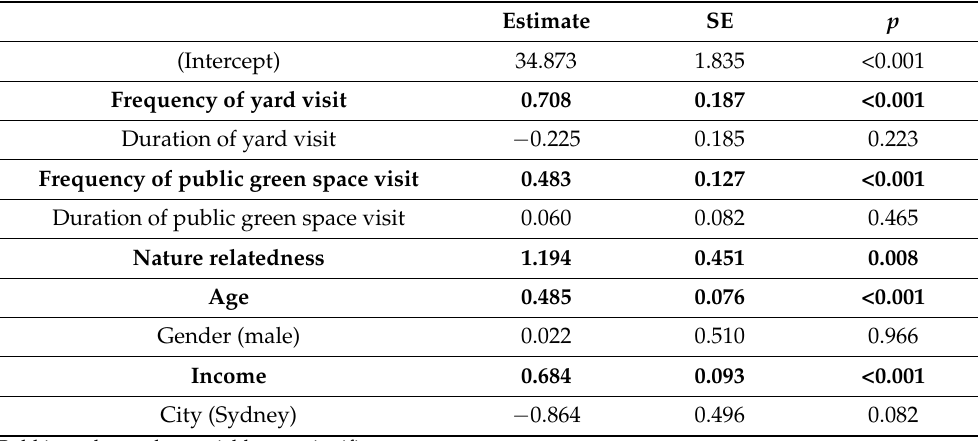
Table 1. The associations between personal wellbeing and nature experiences and nature orientation after controlling for demographic factors.